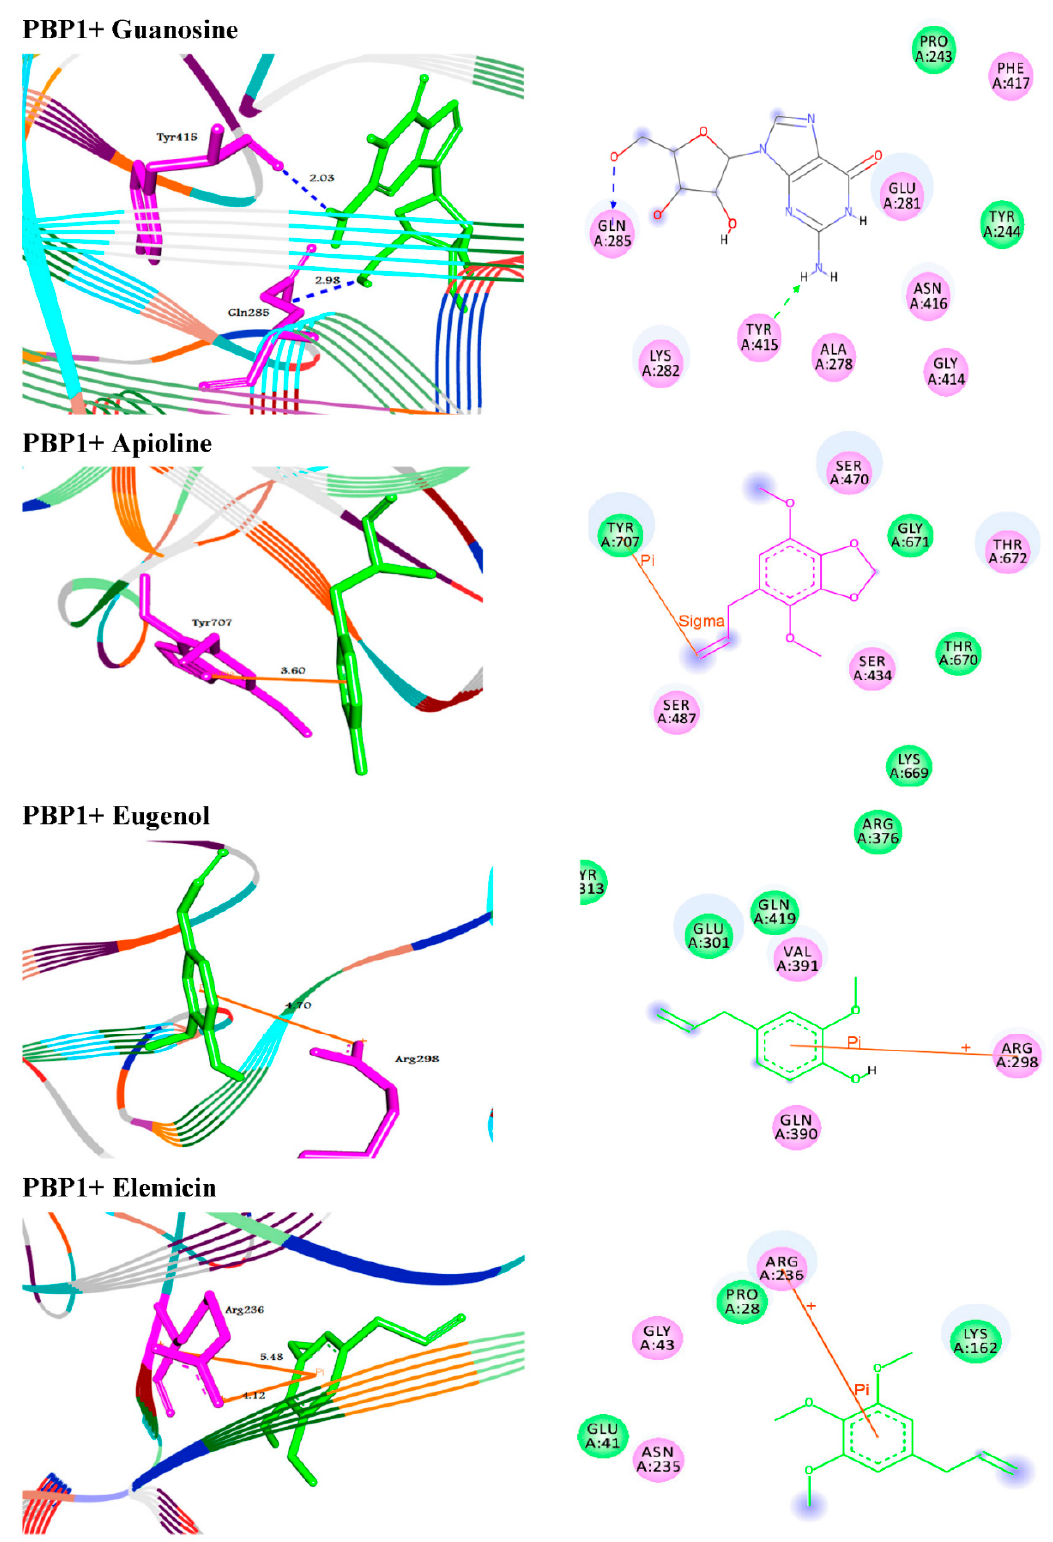
Figure 6. Molecular interactions of Guanosine, Apioline, Eugenol, and Elemicin with penicillin-binding protein 1 (PBP1) in Acinetobacter baumannii . Shown are the 3D ( left ) and 2D ( right ) binding modes upon docking. HBs are represented in blue and green dotted line colors while π - interactions are shown in yellow.